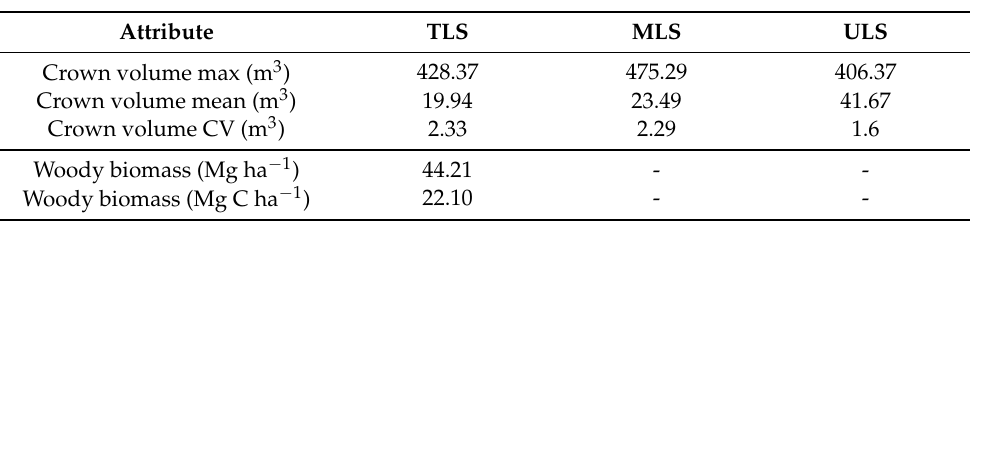
Table 3. Summary statistics of individual tree attributes collected by the three LiDAR